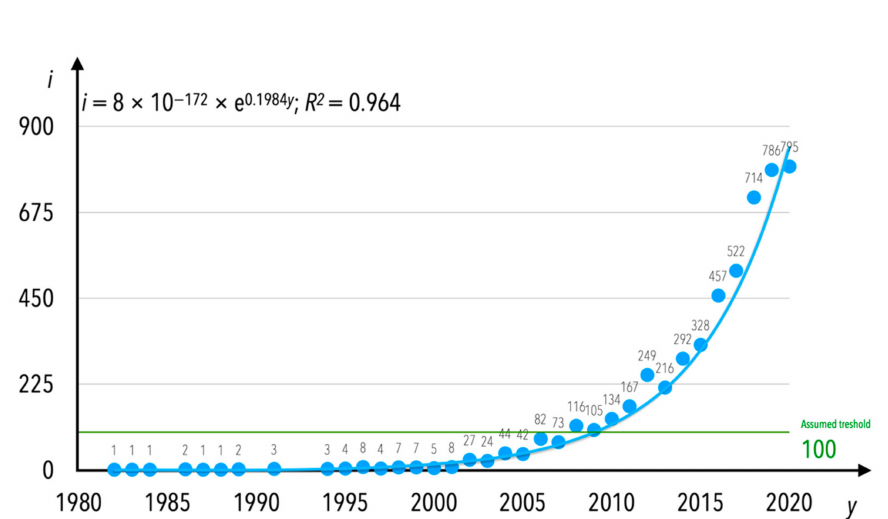
Figure 4. Number of publications ( i ) in the research area of condition monitoring per year ( y